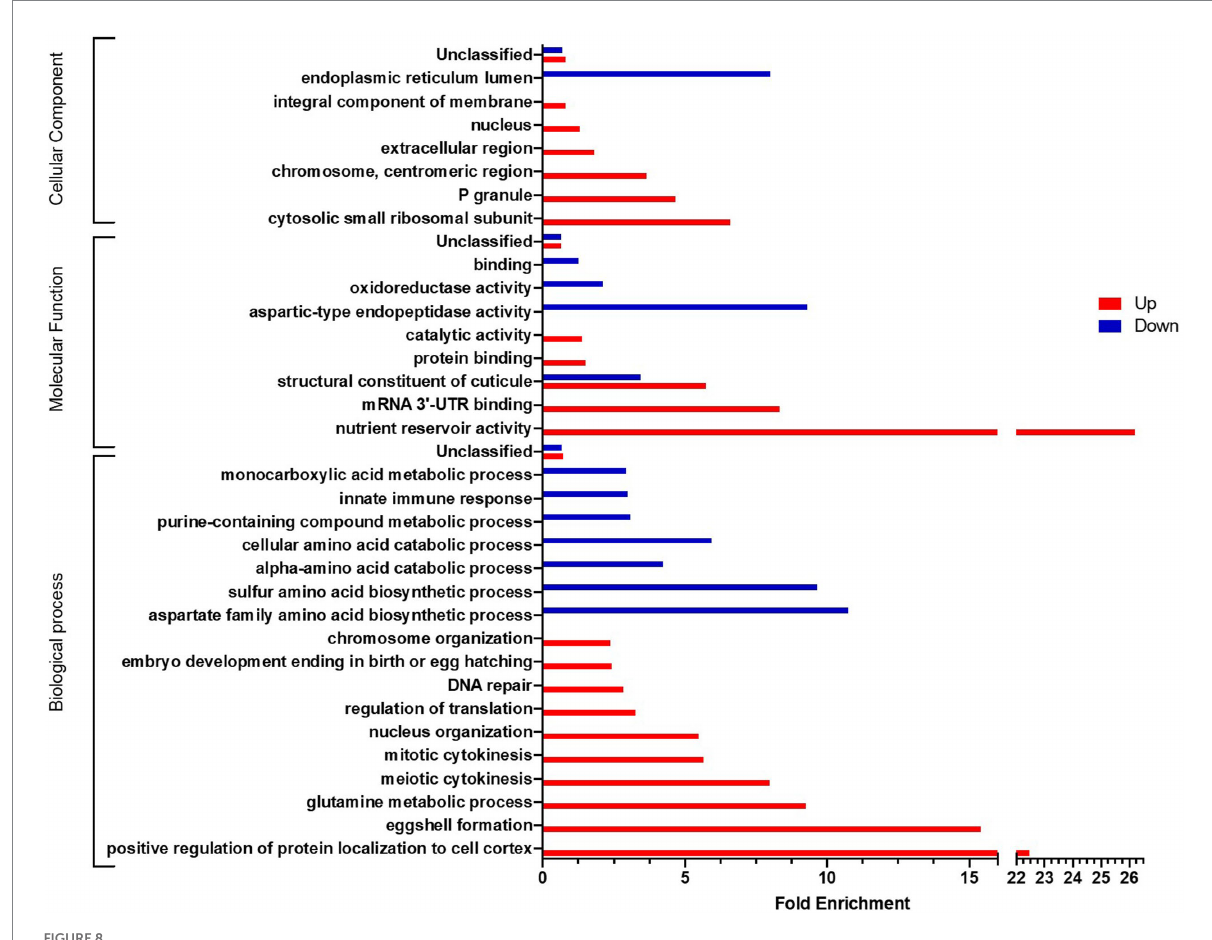
FIGURE 8 GO analyses of differentially expressed genes after a L. rhamnosus Lcr35 ® curative treatment compared to an un-treated candidiasis. Only GO terms significantly enriched (value of p and false discovery rate < 0.05) are